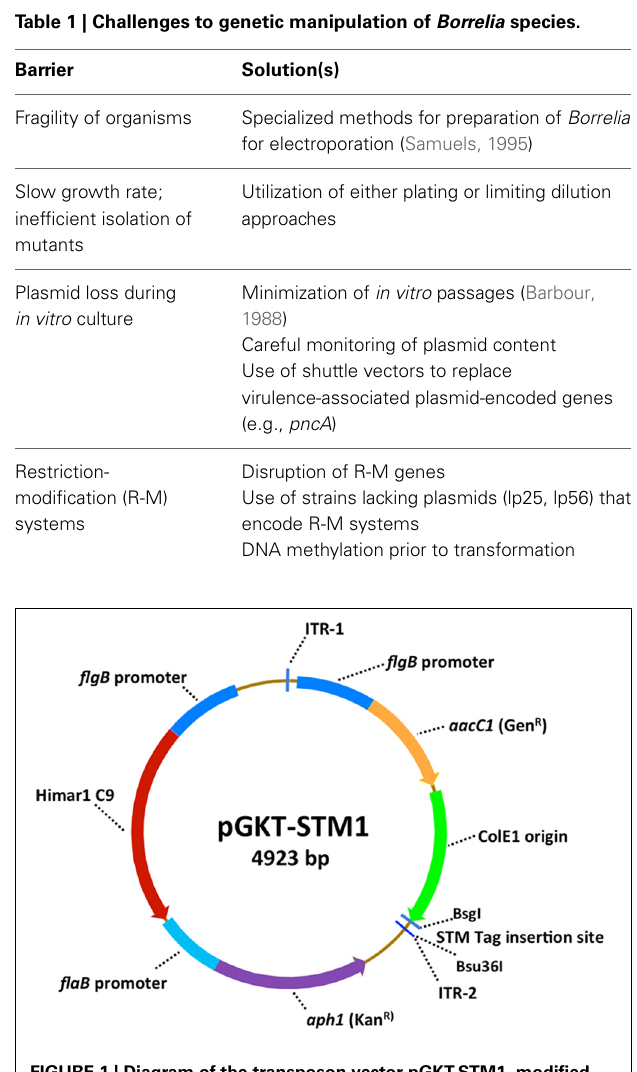
FIGURE 1 | Diagram of the transposon vector pGKT-STM1, modified from the Borrelia -enhanced transposon deliver suicide vector pGKT of Stewart et al. (Stewart and Rosa, 2008). Features of pGKT include the use of B. burgdorferi flgB and flaA promoters to increase the efficiency of expression of the Himar1 c9 transposase and the gentamicin and kanamycin antibiotic resistance markers. The transposable element is flanked by the inverted tandem repeats ITR-1 and ITR-2, and contains the aacC1 gentamicin resistance cassette and the ColE1 origin of replication (to permit plasmid replication in E. coli and transposon insertion site rescue) (Stewart et al., 2004). The modification in pGKT-STM1 and other STM derivatives is the addition of a unique 7-bp signature tag close to